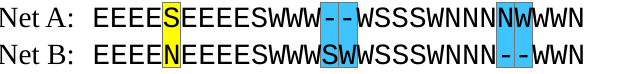
Figure 4. One of the optimal alignments of strings representing the polygons from Figure 3. A mismatch is marked in yellow, while insertions are marked in